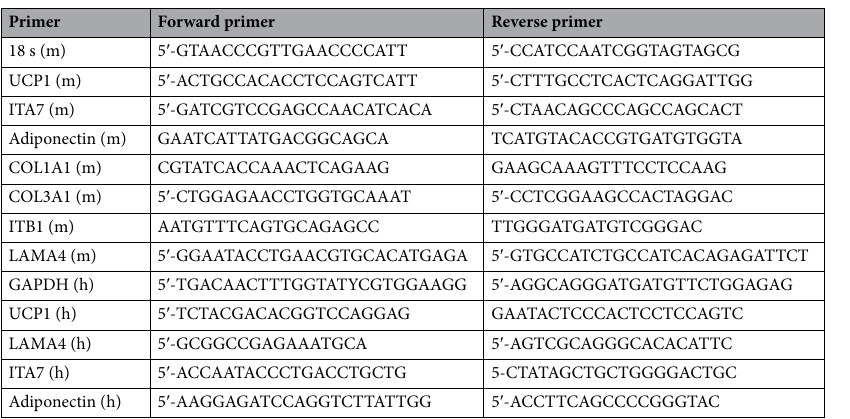
Table 1. Quantitative real-time polymerase chain reaction primer